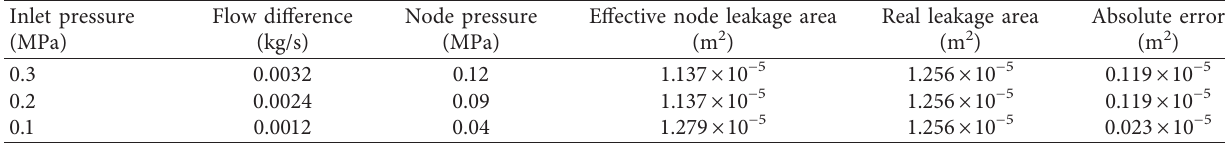
Table 3: The third test of X 5 node leakage parameters under different pressures.